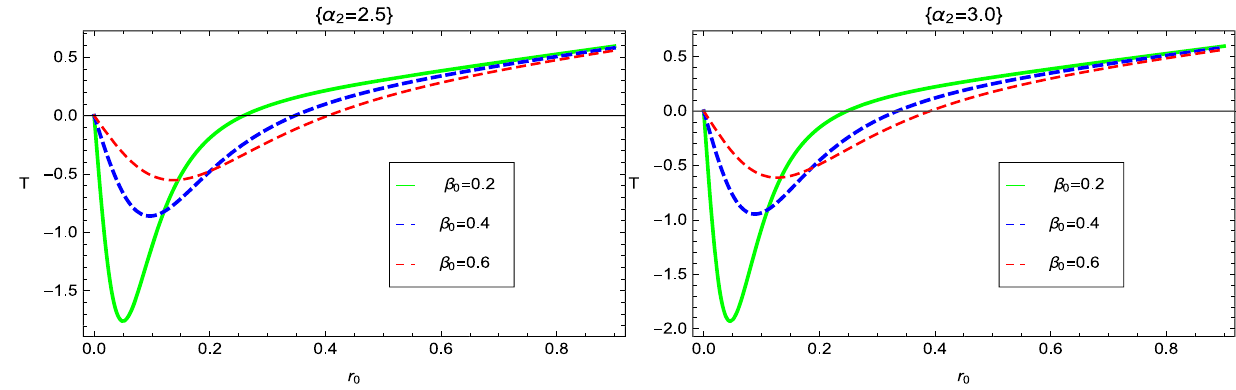
Fig. 7 Temperature T plot with fixed value of α 2 = 2 . 5 and β 0 = ( 0 . 2 , 0 . 4 , 0 . 6 ) {left} and α 2 = 3 . 0 and β 0 = ( 0 . 2 , 0 . 4 , 0 . 6 ) {right}